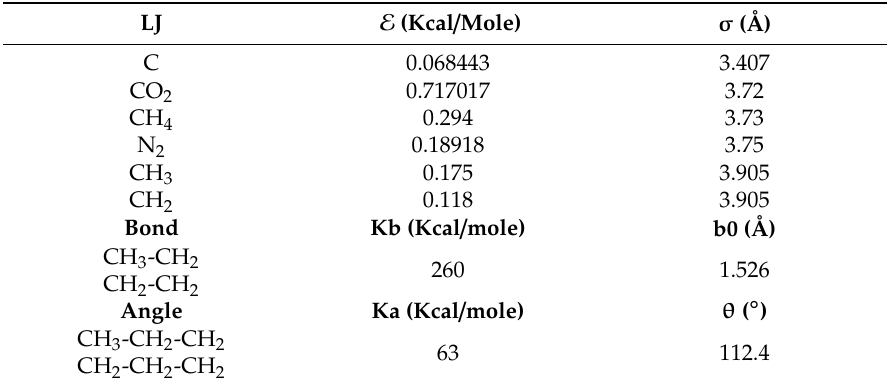
Figure 1. System setup and the simulation evolution: ( a ) the initial setup of the system where the hydrocarbons are placed inside the pore and the Enhanced Oil Recovery (EOR) gas (in this case CO 2 ) is placed outside; ( b ) the hydrocarbon equilibration; ( c ) the EOR gas equilibration; ( d ) the system extended to include a production region, where the pore was opened for production and a constant-velocity wall is allowed; ( e ) the system after 0.1 ns; ( f ) the system after 0.5 ns; ( g ) the system after 1 ns. Color code: red is graphite, blue is gas and yellow is hydrocarbon. Table 1. Force field parameters of the system